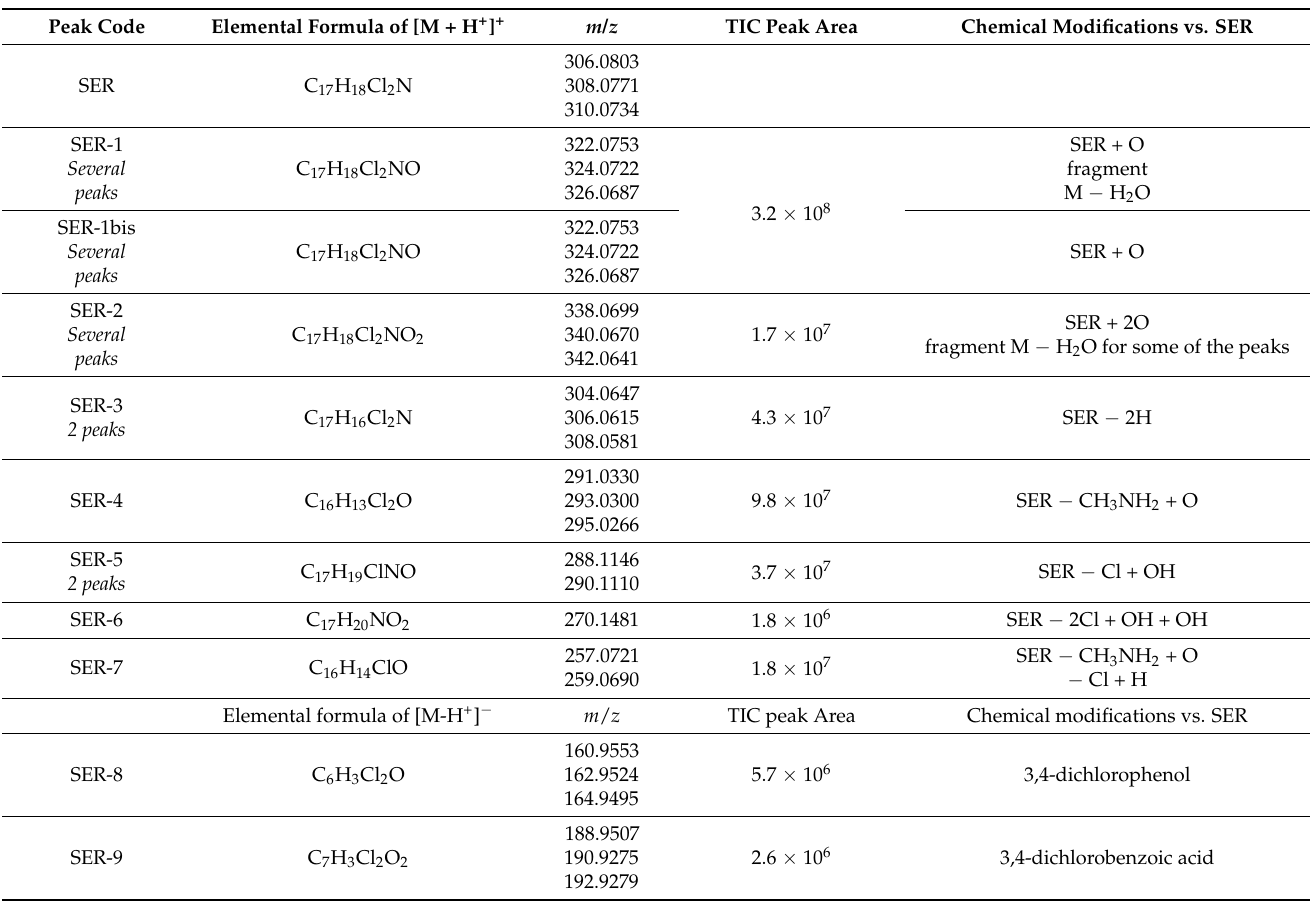
Table 1. HRMS data of the main photoproducts of SER after 8 h of irradiation in the presence of WEOM. Percentage of conversion =